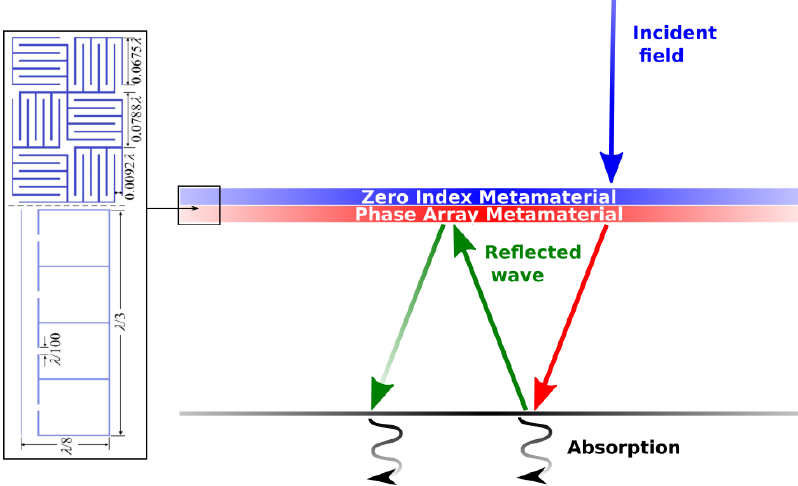
Figure 8. Noise trapping unit cell, from [63] and the functioning scheme of a noise trapping concept. The incident wave is allowed to pass through the metamaterial, and it is steered by the phase array into an absorbing material. The reflected fraction of the sound cannot escape and multiple reflections and absorption